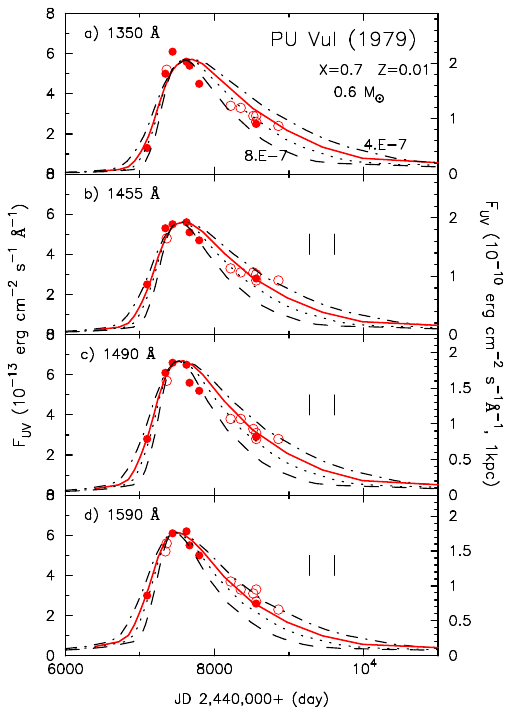
Fig. 1. UV light curves for the four continuum bands: (a) 1350 ˚A, (b) 1455 ˚A, (c) 1490 ˚A and (d) 1590 ˚A. Theoretical light curves are also shown for an assumed distance of 1 kpc (with right-side axis); They are for a 0.6 M ⊙ WD with chemical composition of the envelope X = 0 : 7 and Z = 0 : 01 and four different optically-thin wind mass-loss rates. Dash-dotted curves: 4 (cid:2) 10 − 7 M ⊙ yr − 1 , red solid curves: 5 (cid:2) 10 − 7 M ⊙ yr − 1 , dotted curves: 6 (cid:2) 10 − 7 M ⊙ yr − 1 and dashed curves: 8 (cid:2) 10 − 7 M ⊙ yr − 1 . Short vertical lines in panels (b), (c) and (d) show the period of the second eclipse at the optical V band between JD 2 449 270 and 2 449 610. Among the observational data, the open circles denote those which have low accuracy because they were observed with short exposures ( < 1000 s) or were obtained from very noisy